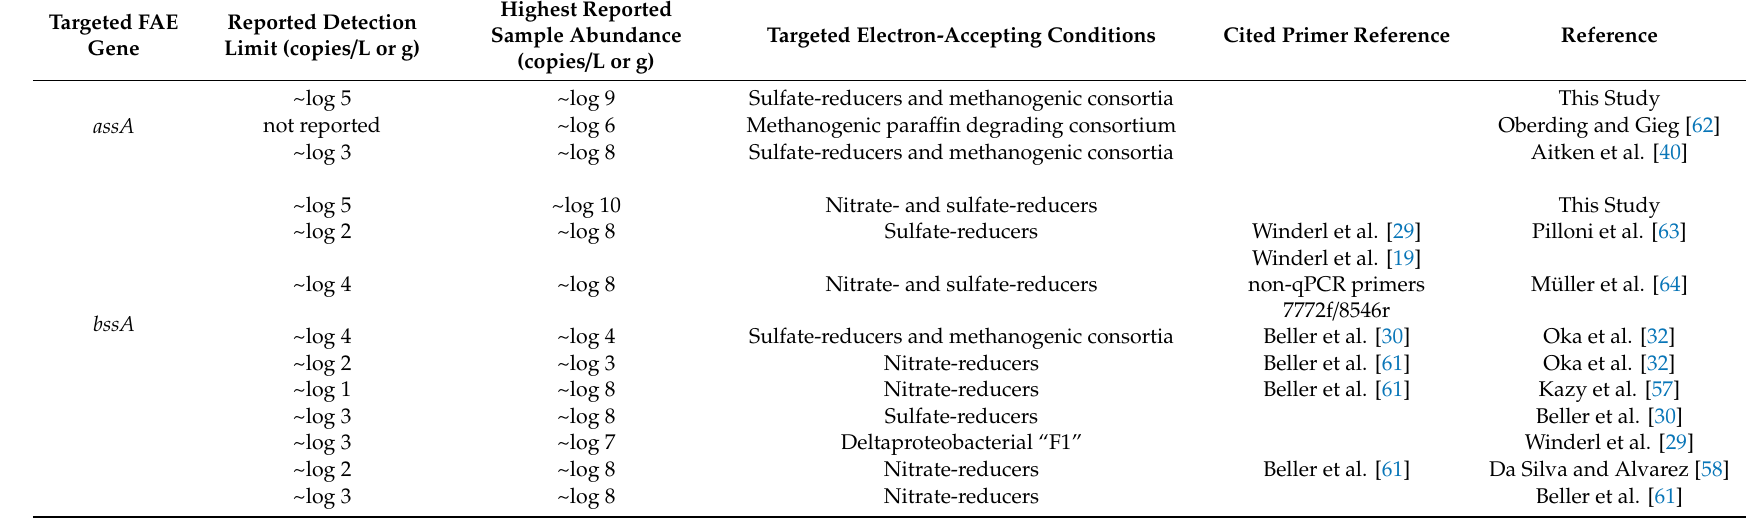
Table 4. Comparisons of approximate reported assA and bssA gene abundances reported in literature and in the present study. Note that abundances reported in this study are up to 2 log greater than other studies, in both detection limit and in highest reported